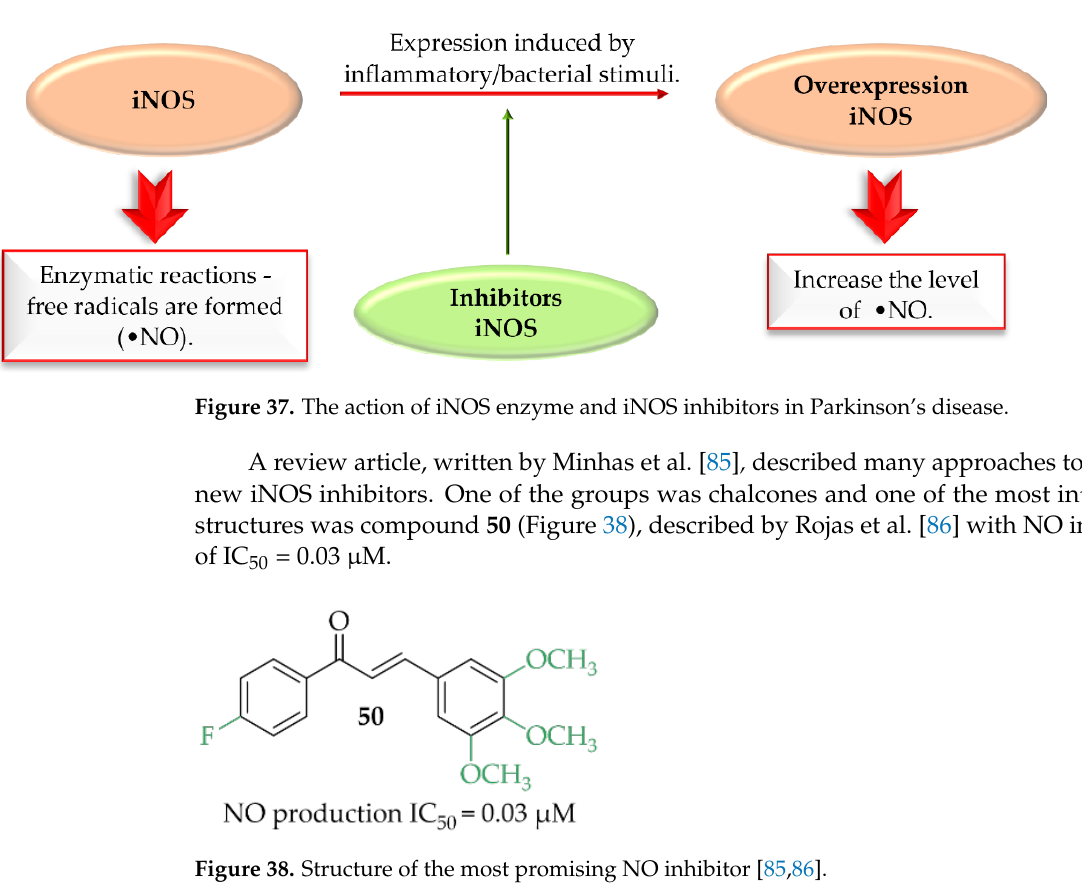
Figure 38. Structure of the most promising NO inhibitor [85,86] .